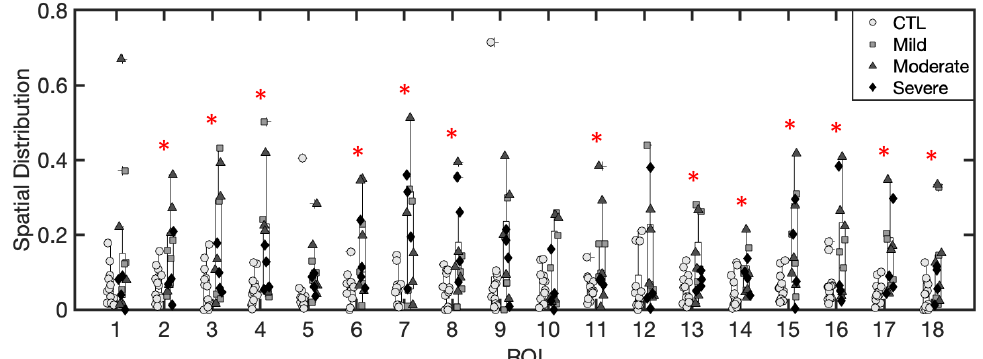
Figure 8. Average spatial distribution per ROI in control and CF subjects where ROIs 1–9 are from the right lung and ROIs 10–18 are from the left lung. Red asterisks denote a statistically significant increase from control to CF subjects in the ROI ( p < 0.05).